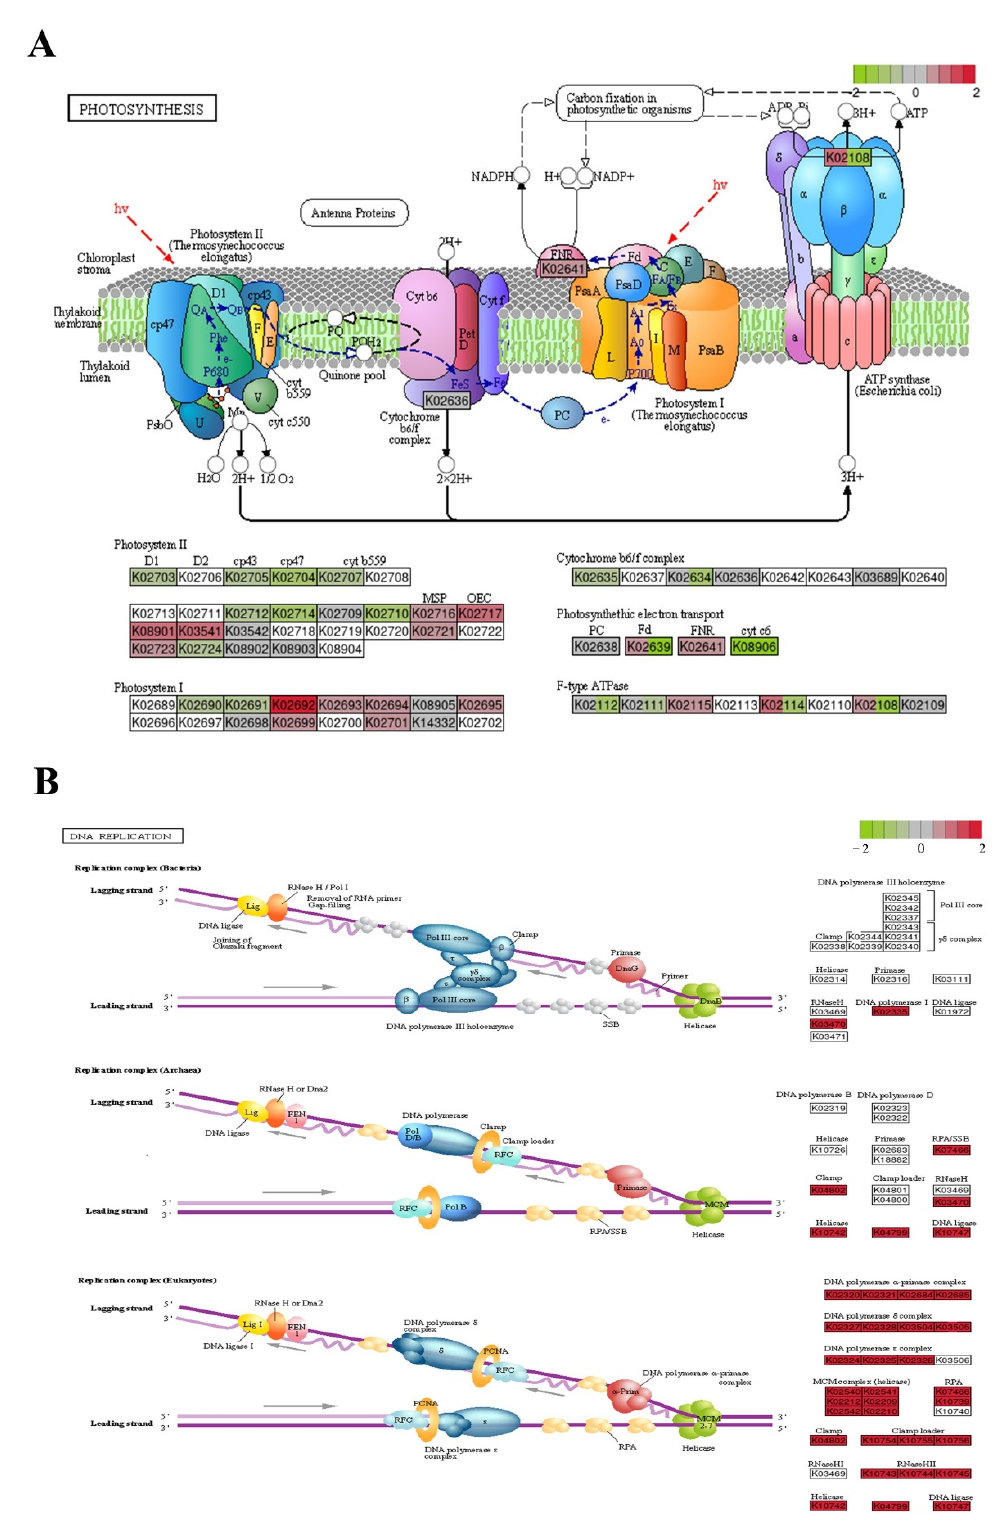
Figure 7. Changes in expression of KEGG-annotated genes in photosynthesis and DNA replication pathways ( A , B ); red squares: significantly up-regulated in the treatment group compared to CK, green squares: significantly down-regulated in the treatment group compared to CK. CK: control; LD: low dose; MD: moderate dose; HD: higher dose.